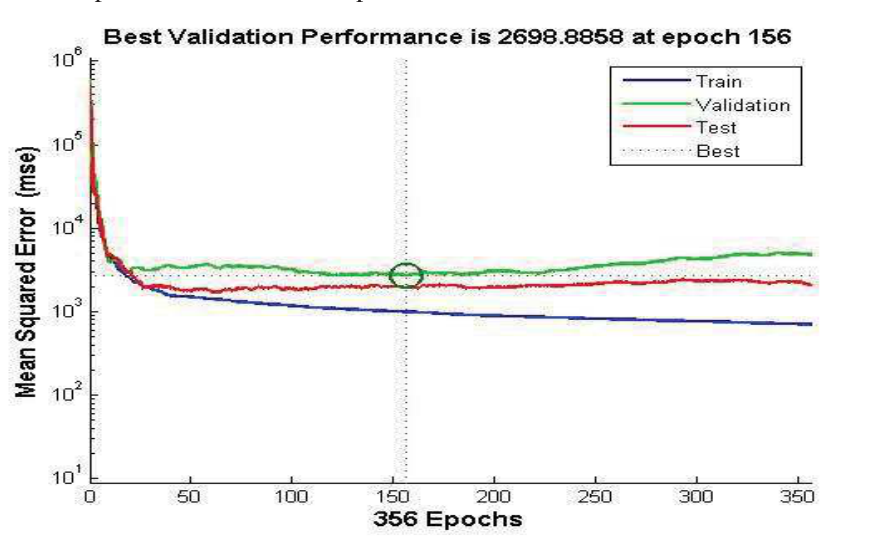
Fig. 14. Shows validation best performance relationship in the ANNs